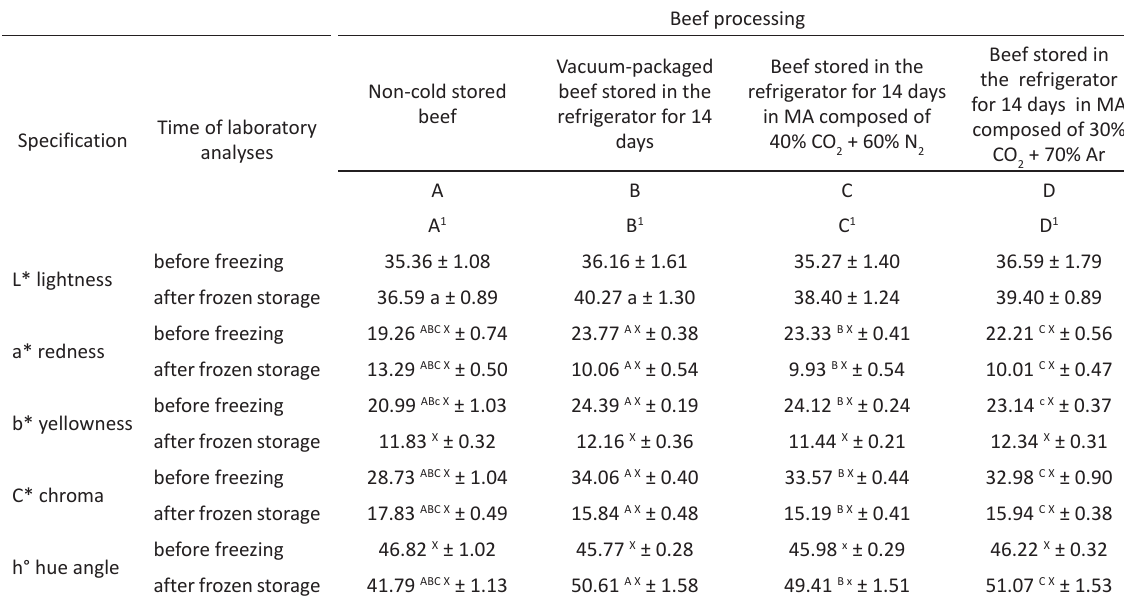
Table 3. Meat color